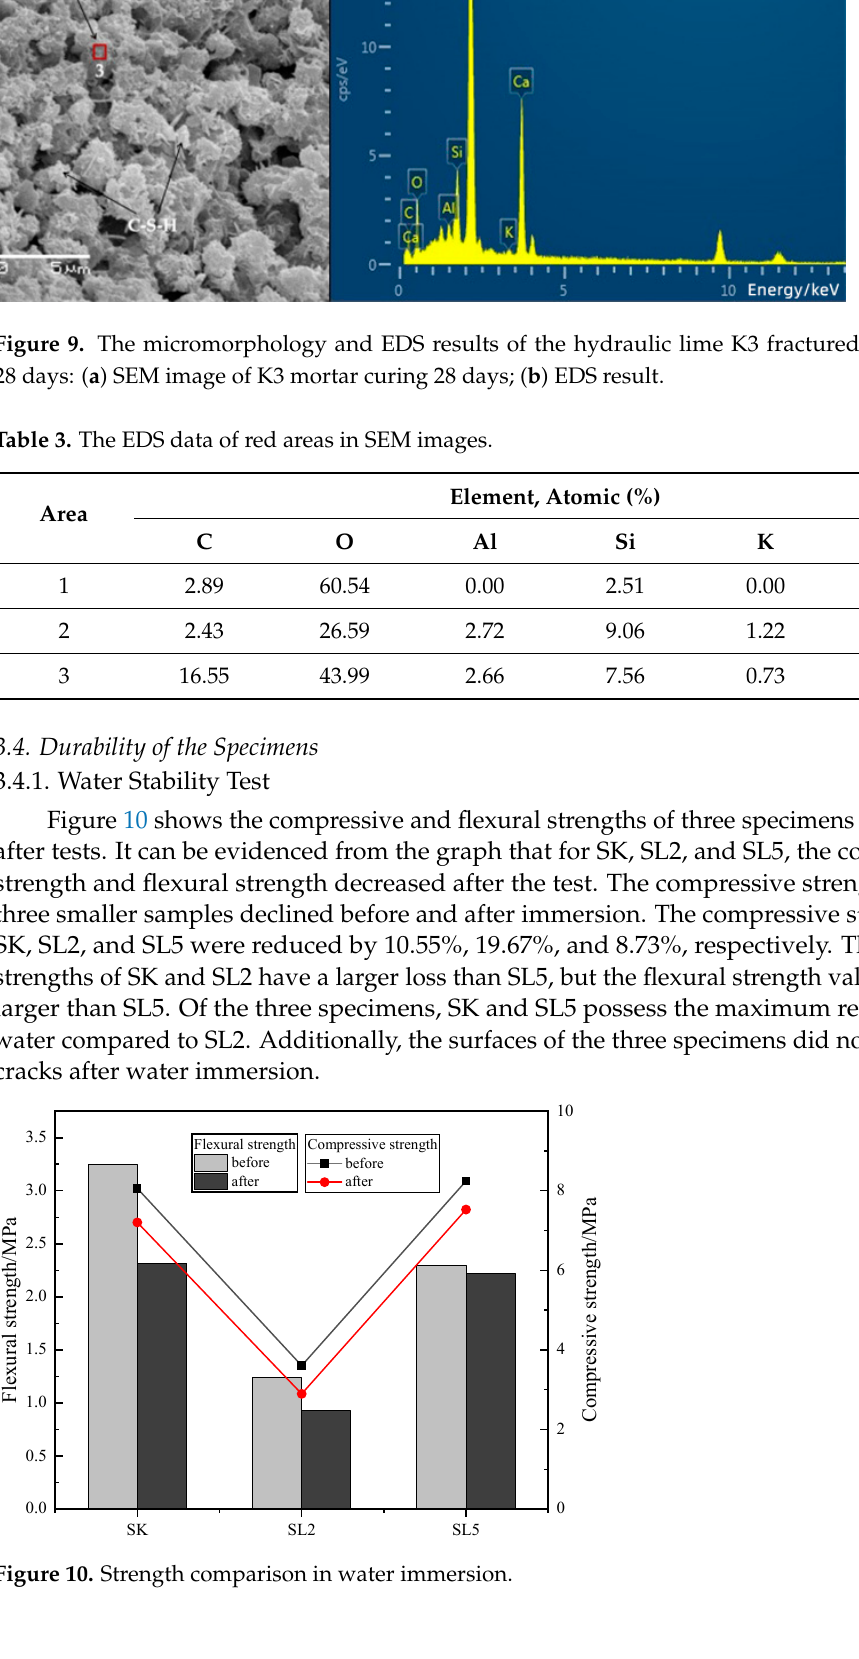
Figure 10. Strength comparison in water immersion.